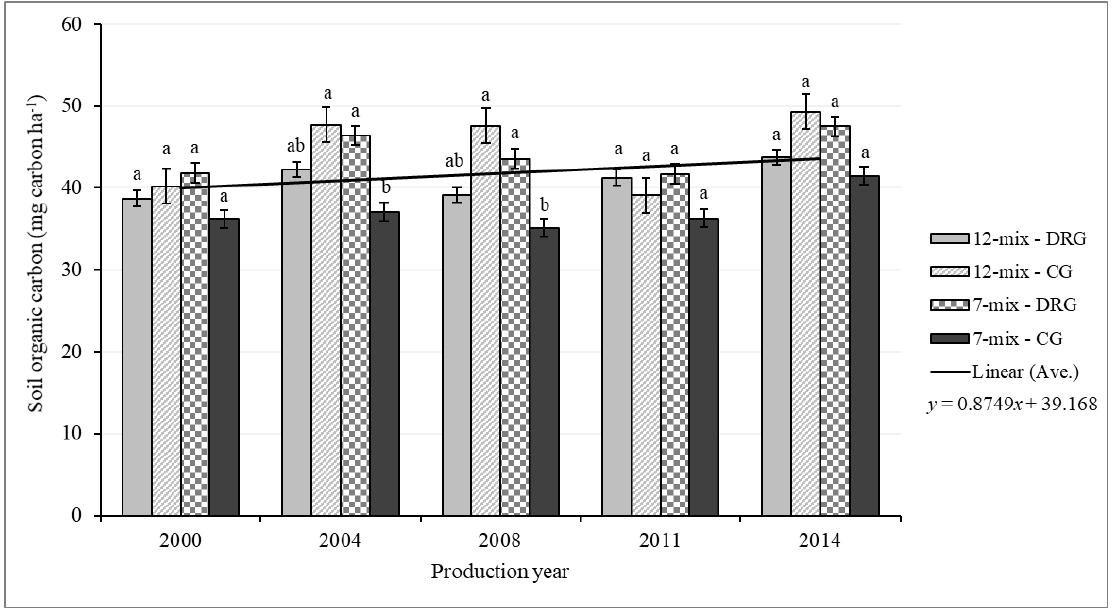
Figure 2. Soil organic carbon stock adjusted for equivalent soil mass of 4000 Mg ha − 1 within a 30 cm depth for the seed mixture (7-mix, 12-mix) × grazing system (CG = continuous grazing, DRG = deferred rotational grazing) interaction within the production year of 2000 to 2014. Significance difference among treatment within a year was indicated by lower case letters ( a, b ) and standard error of the means was represented by error bars.